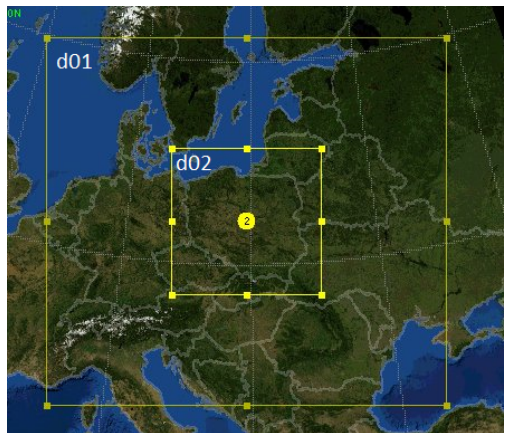
Figure 2. Geographical coverage of nested domains used in the WRF